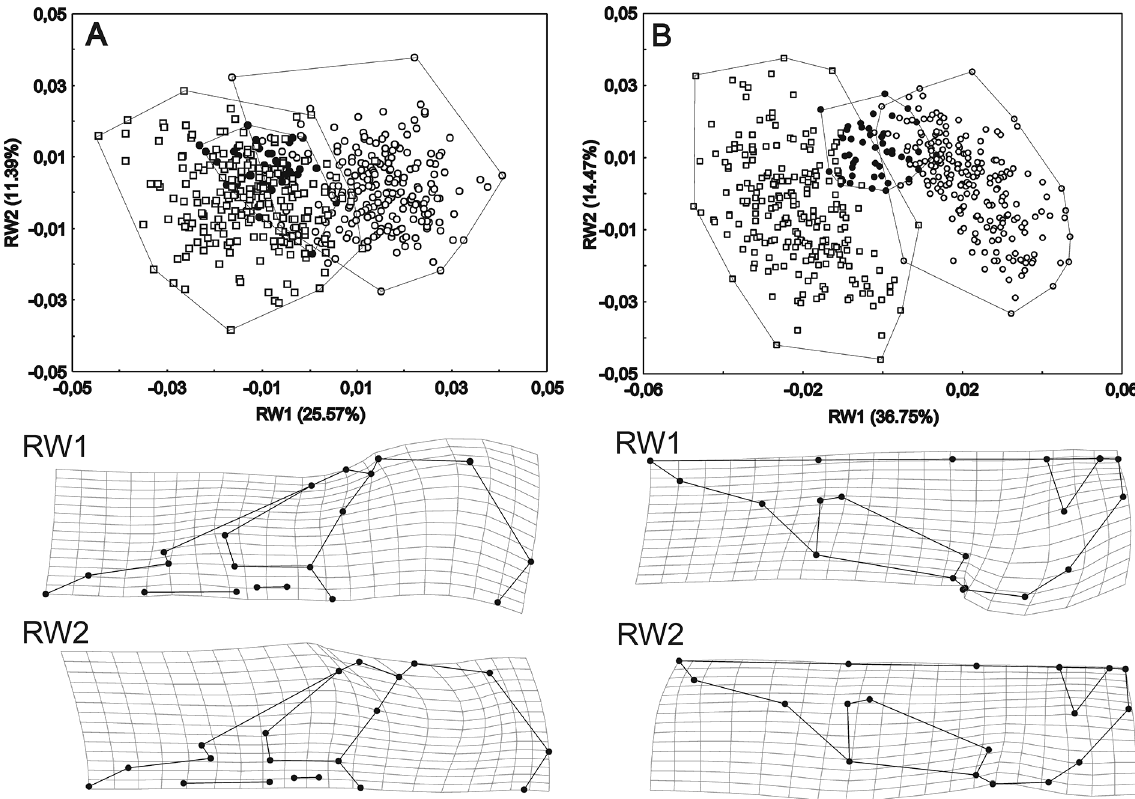
Fig. 3. Scatter plot of RW1 versus RW2 of the (A) ventral and (B) dorsal cranium of Meriones crassus Sundevall, 1842 and M. libycus Lichtenstein, 1823. Legends: ○ = M. crassus (other than Western Zagros), ● = M. crassus of Western Zagros, □ = M. libycus . Below: thin-plate spline deformation grids visualize shape variation as expressed by the first two RWs axes (grids represent shape difference between configurations corresponding to lowest and highest RW-values). For the numbering of landmarks, see Fig.